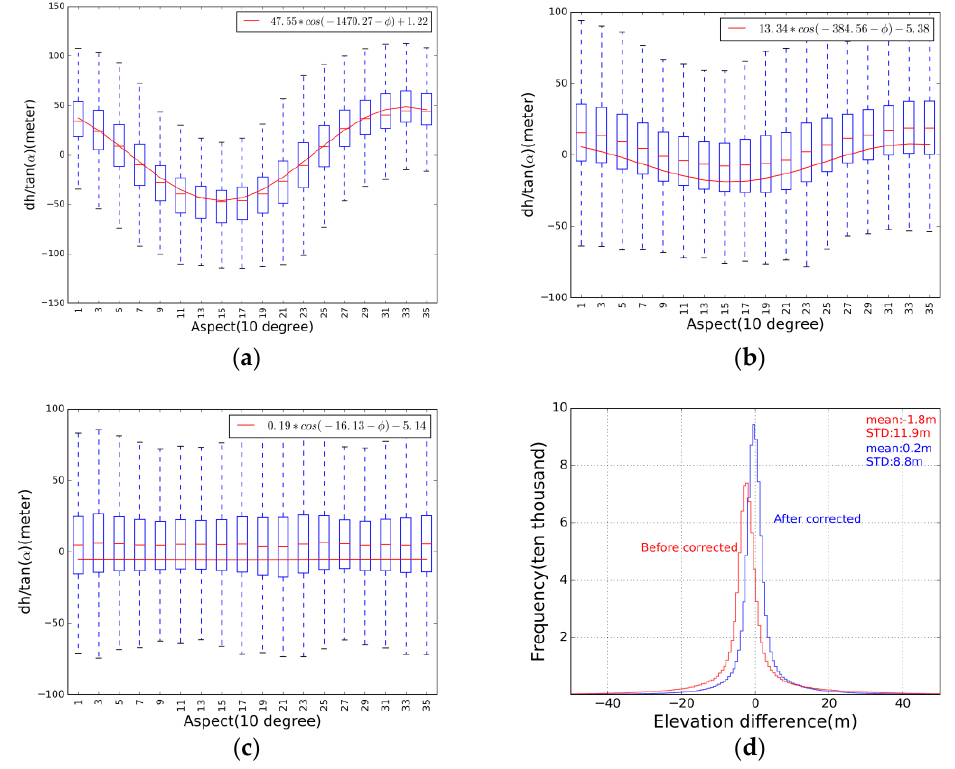
Figure 1. ( a ) The relationship between aspect and the elevation difference of GLAS data and SRTM DEM before universal co-registration correction; ( b ) the relationship between the aspect and the elevation difference of GLAS and SRTM after the first universal co-registration; ( c ) The relationship between the aspect and the elevation difference of GLAS and SRTM after the final universal co-registration; and ( d ) the histogram of the elevation differences before and after applying the universal co-registration.